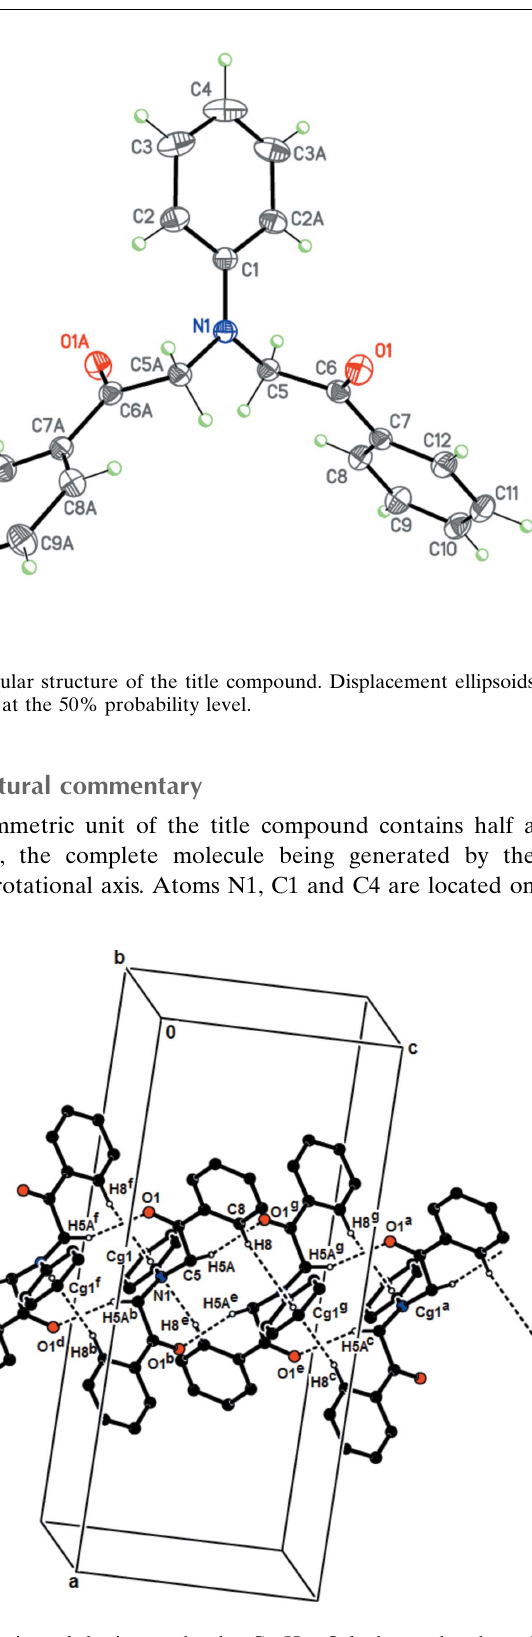
Figure 3 View of the packing down the c axis showing C—H (cid:2)(cid:2)(cid:2) O hydrogen bonds (cid:4) z ; ( c ) x + 3 and and C—H (cid:2)(cid:2)(cid:2) (cid:2) interactions in the title compound. The hydrogen , (cid:4) y + 1 , (cid:4) z + 1; ( d ) 1 (cid:4) x , 2 2 2 atoms not involved in the hydrogen bonds have been omitted for clarity. + z ; ( g ) x , 1 (cid:4) y , 1 + z . 2 2